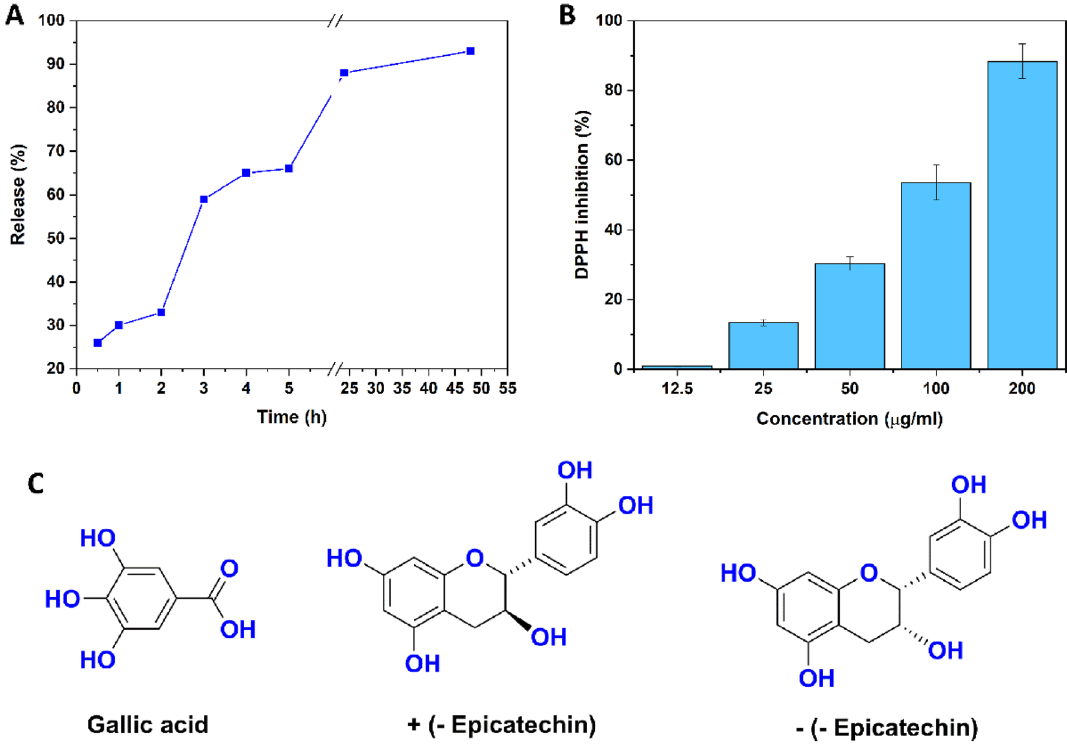
Figure 4. Release profile and antioxidant activity. ( A ) Release profile of the GSE from the nanofibrous mat. ( B ) Antioxidant activity of GSE. ( C ) Some available compounds responsible for antioxidant activity of the GSE.